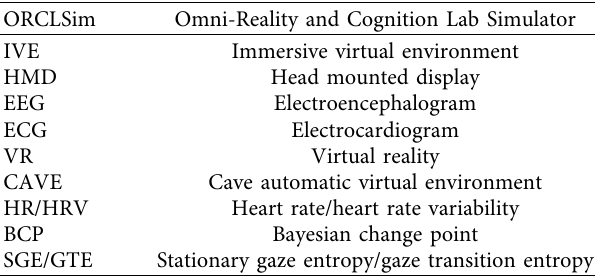
Table 1: List of